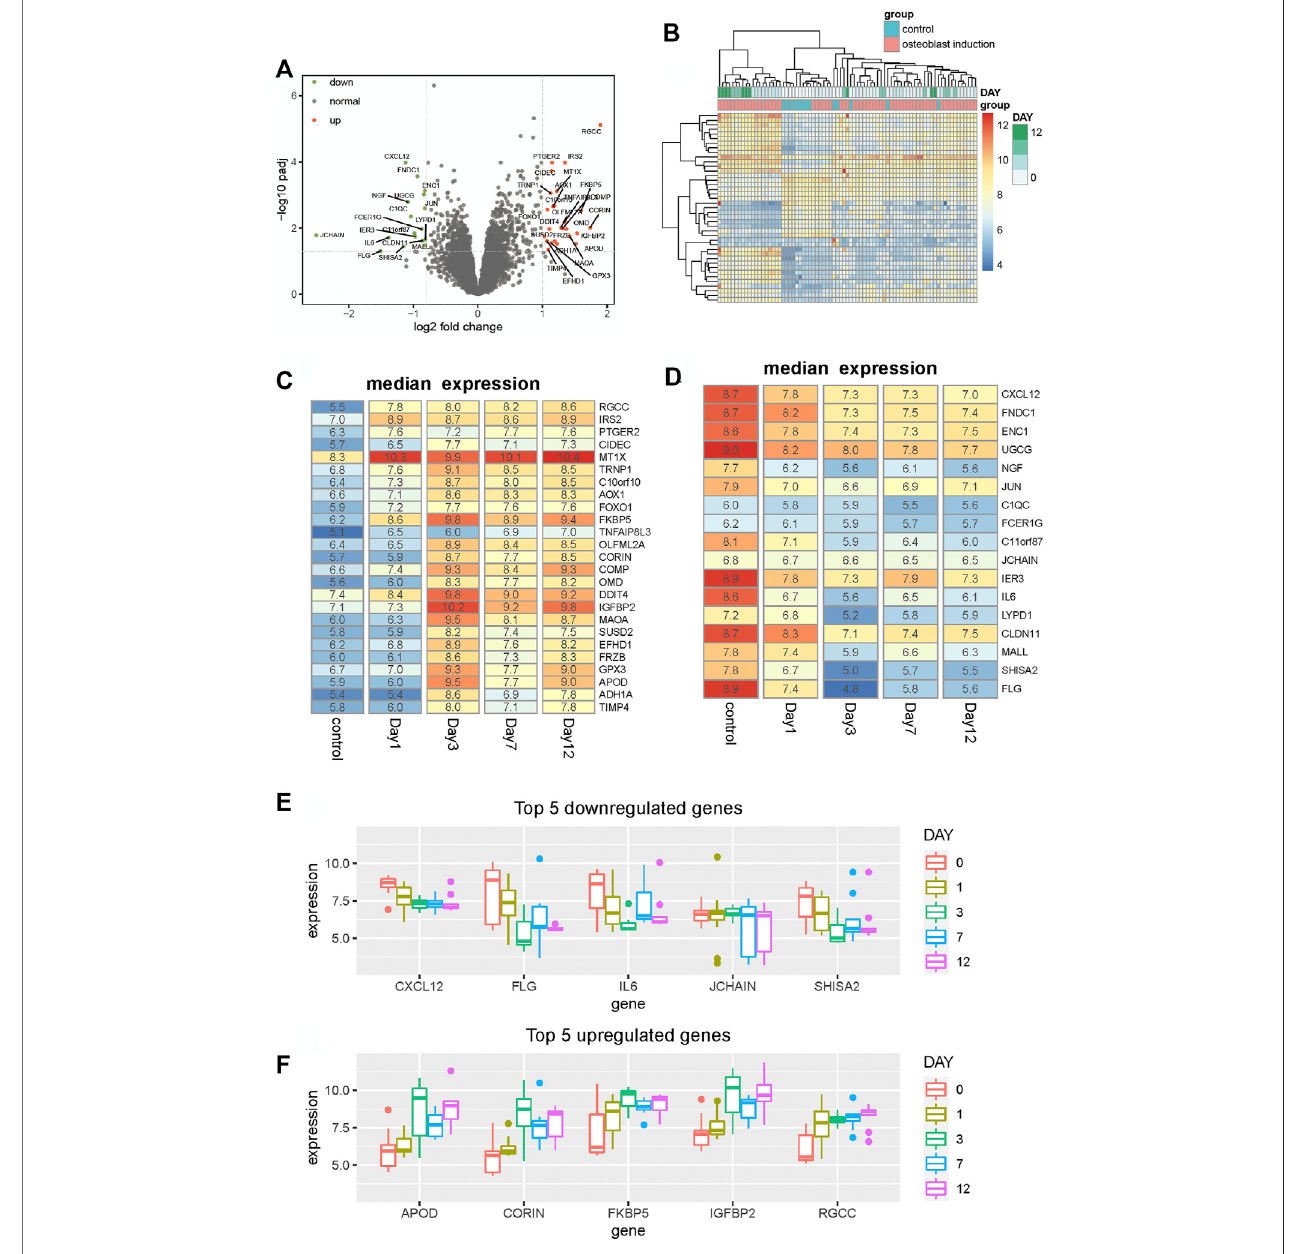
FIGURE 1 | Identi fi cation of differentially expressed genes between hBMSCs and osteogenically induced samples. (A) Volcano plot shows the differentially expressedgenesbasedonfoldchangeandBH-adjusted p- value.Upregulatedanddownregulatedgenesaredisplayedusingredandbluenodes,respectively. (B) Heat map shows the expression pattern of these differentially expressed genes. Samples are annotated into different groups. Day means the time of osteogenically induced samplesinthedifferentiationprocess. (C,D) Heatmapshowsthemedianexpressionofupregulatedanddownregulatedgenesrespectivelyforsamplesindifferent differentiation stages. (E,F) Boxplot shows the top fi ve downregulated and upregulated genes respectively in the osteogenic